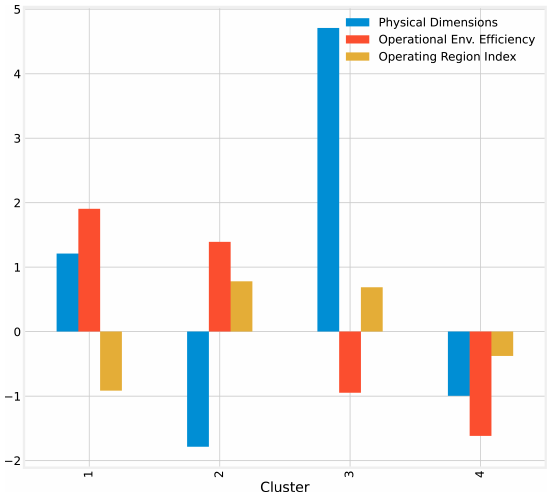
Figure 12. Values of the three indices (PCs) at the centroid of the four clusters identified by the k-means